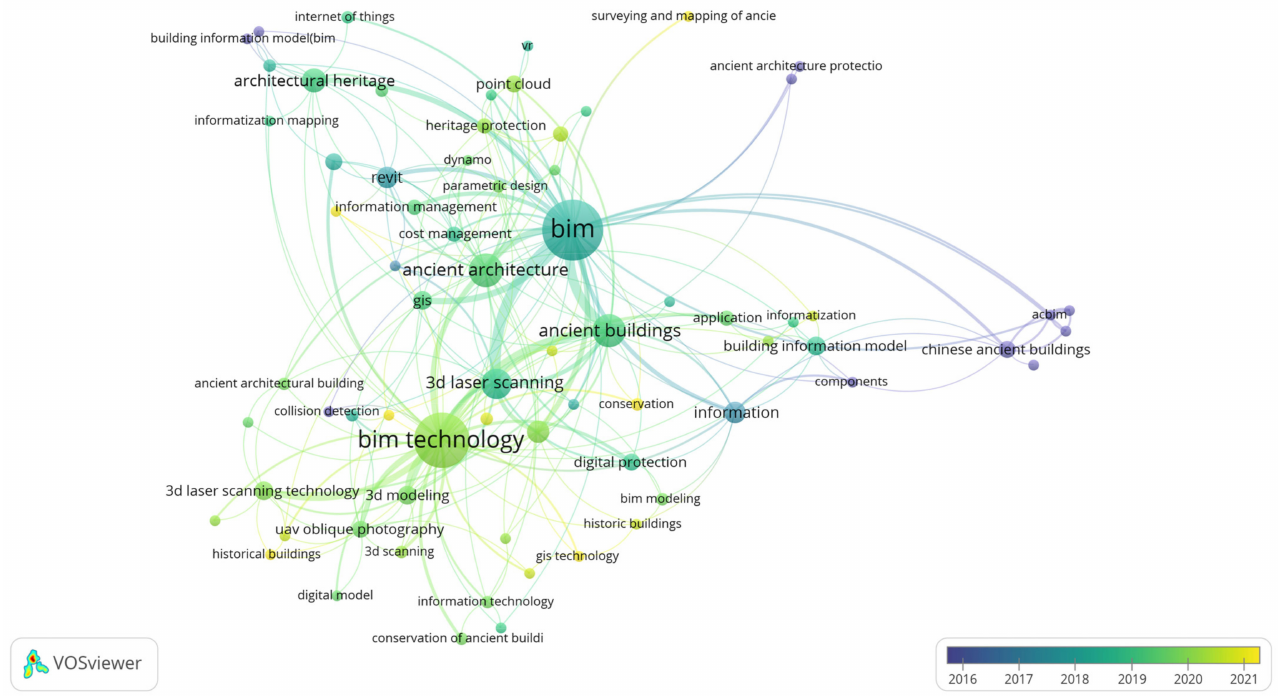
Figure 12. Overlay visualization of the keyword for “BIM” and “architectural heritage” from the 2016 to 2020, created by